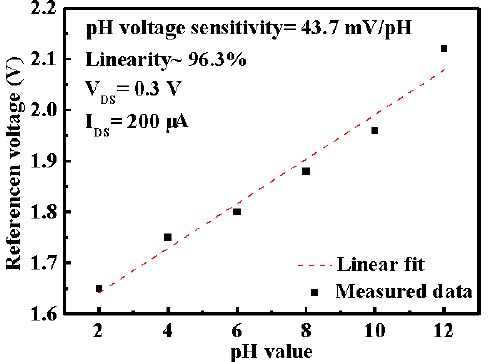
Figure 8. Reference voltage ( V REF ) as a function of pH